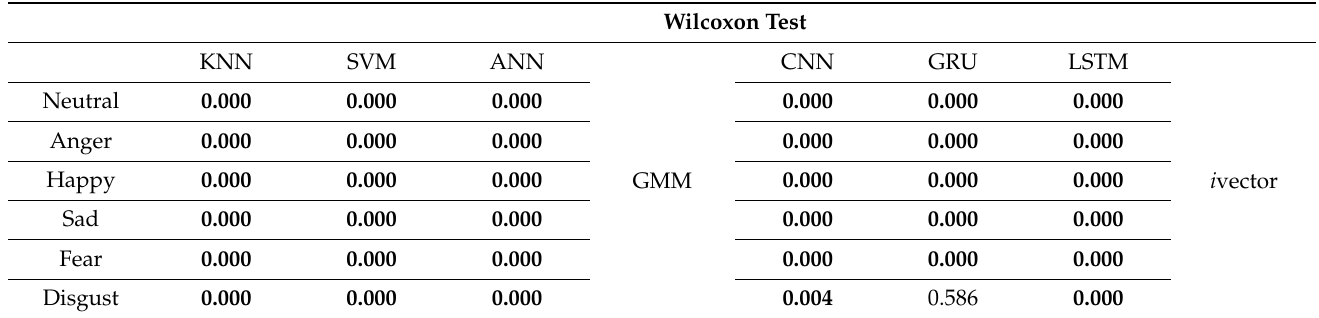
Table 7. p -value using Wilcoxon test for the classical and fine-tuned deep models using the RAVDESS database. Wilcoxon